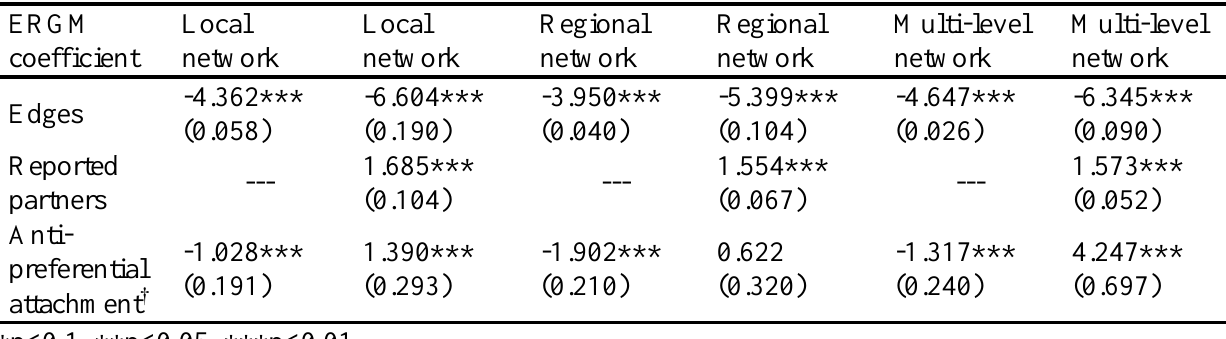
Table A1.5: Model results illustrating the interdependence between the anti-preferential attachment and “reported partners” variable, in the absence of any other model terms. Pendant nodes were not included in any of the